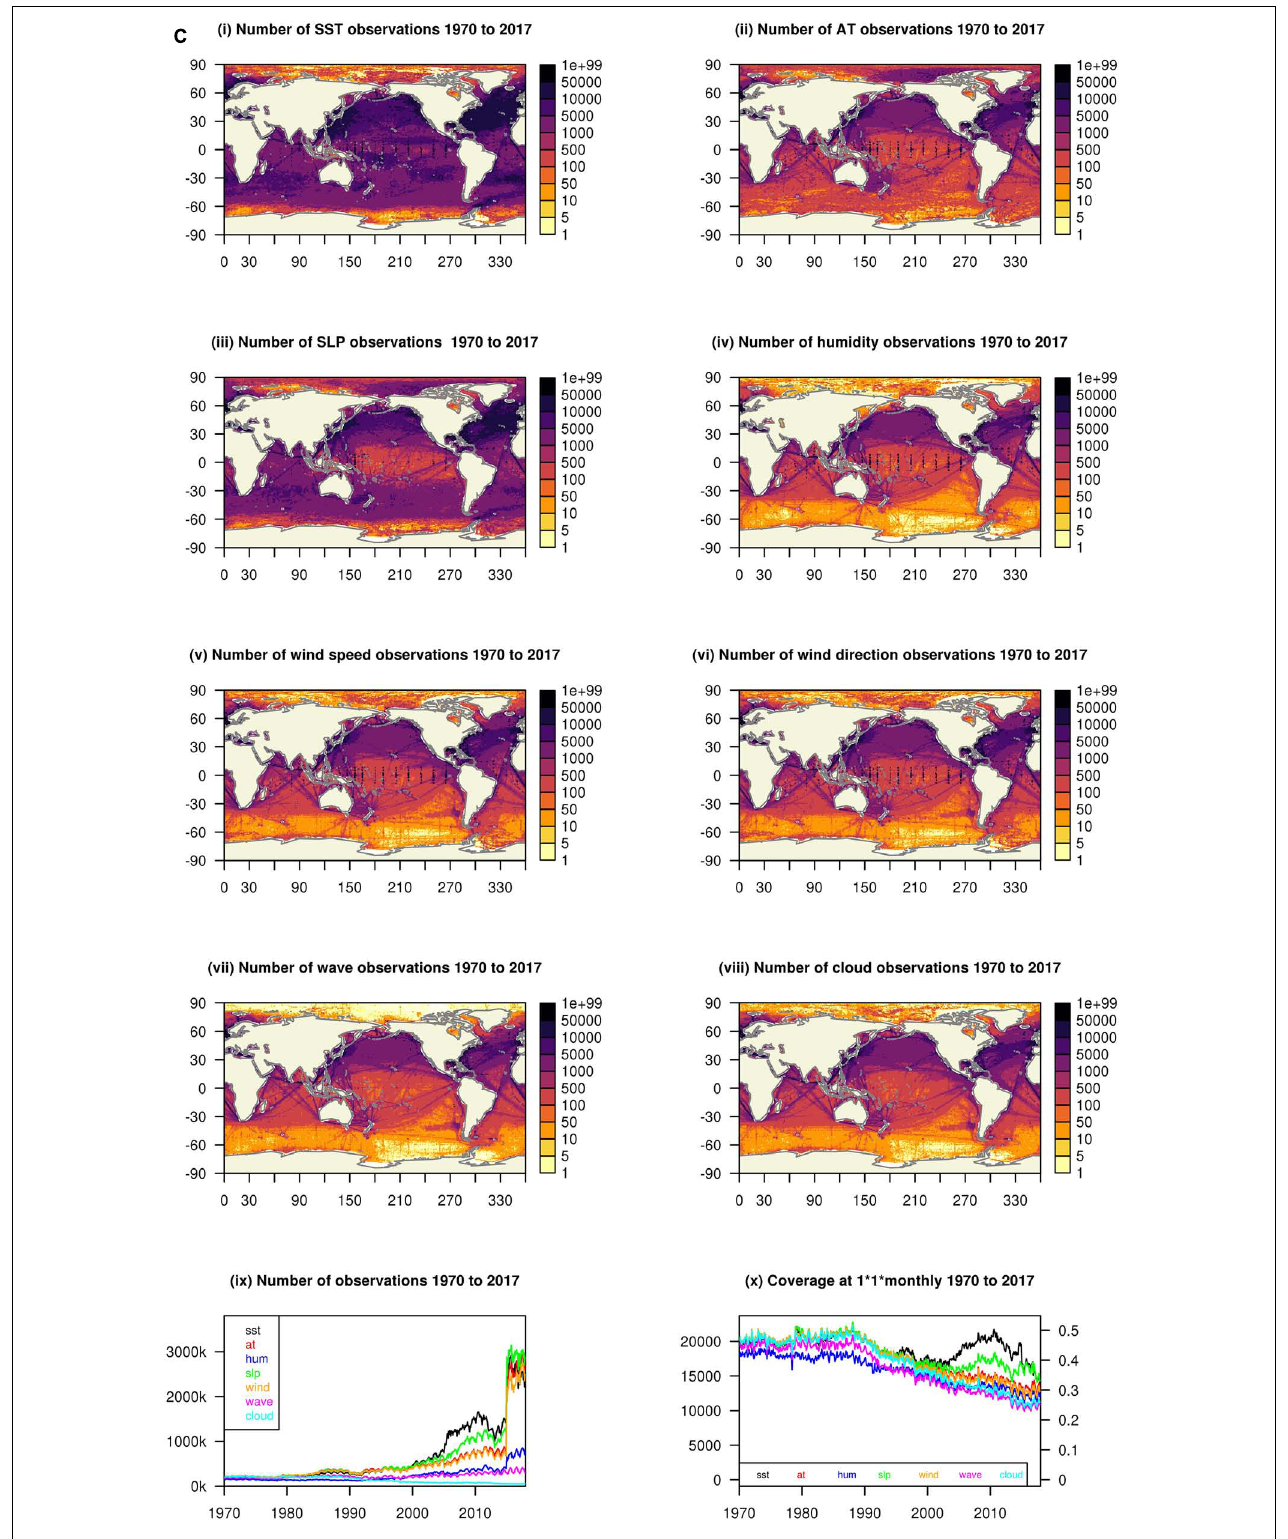
FIGURE 2 | (A) Total number of observations on a 1 ◦ latitude-longitude grid for selected ECVs from ICOADS Release 3.0 over the period, 1800–1899. The lower panels show (ix) the total number of monthly observations and (x) the number of 1 ◦ monthly areas sampled (left axis) and fraction of ocean 1 ◦ areas (right axis). No QC or other data selection has been applied. (B) As 2a but for 1900–1969. (C) As 2a but for 1970–2017.